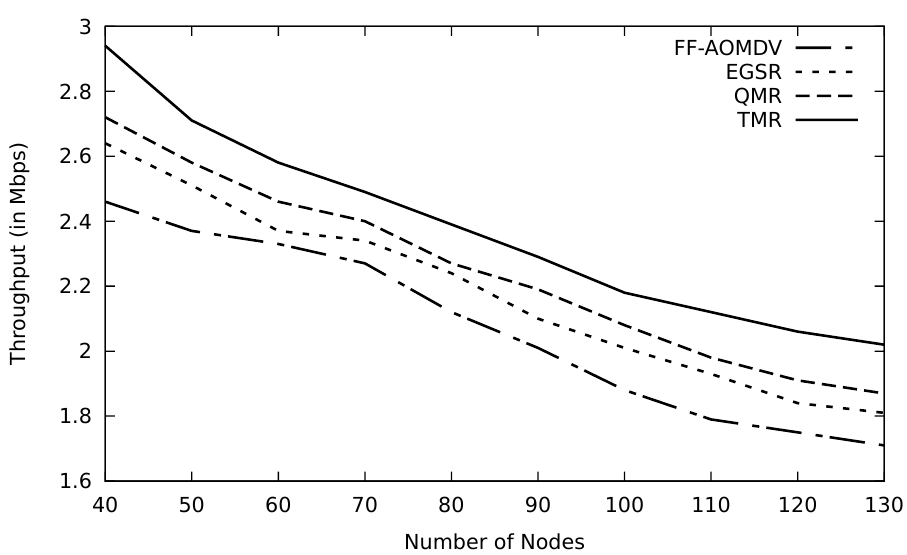
Figure 14. Comparison of FF-AOMDV, EGSR, QMR, and proposed protocol TMR for throughput with number of nodes.